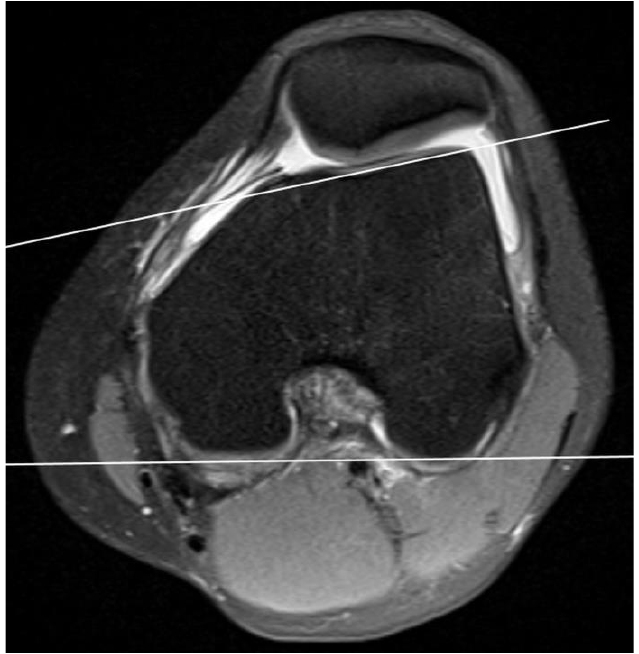
Figure 1. Proximal trochlear articular surface and measuring of lateral trochlear inclination. The morphology of the trochlear facet asymmetry assessed on axial fat-saturated